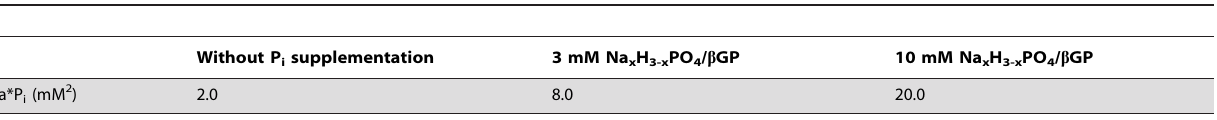
Table 2. Calcium phosphate ion products.